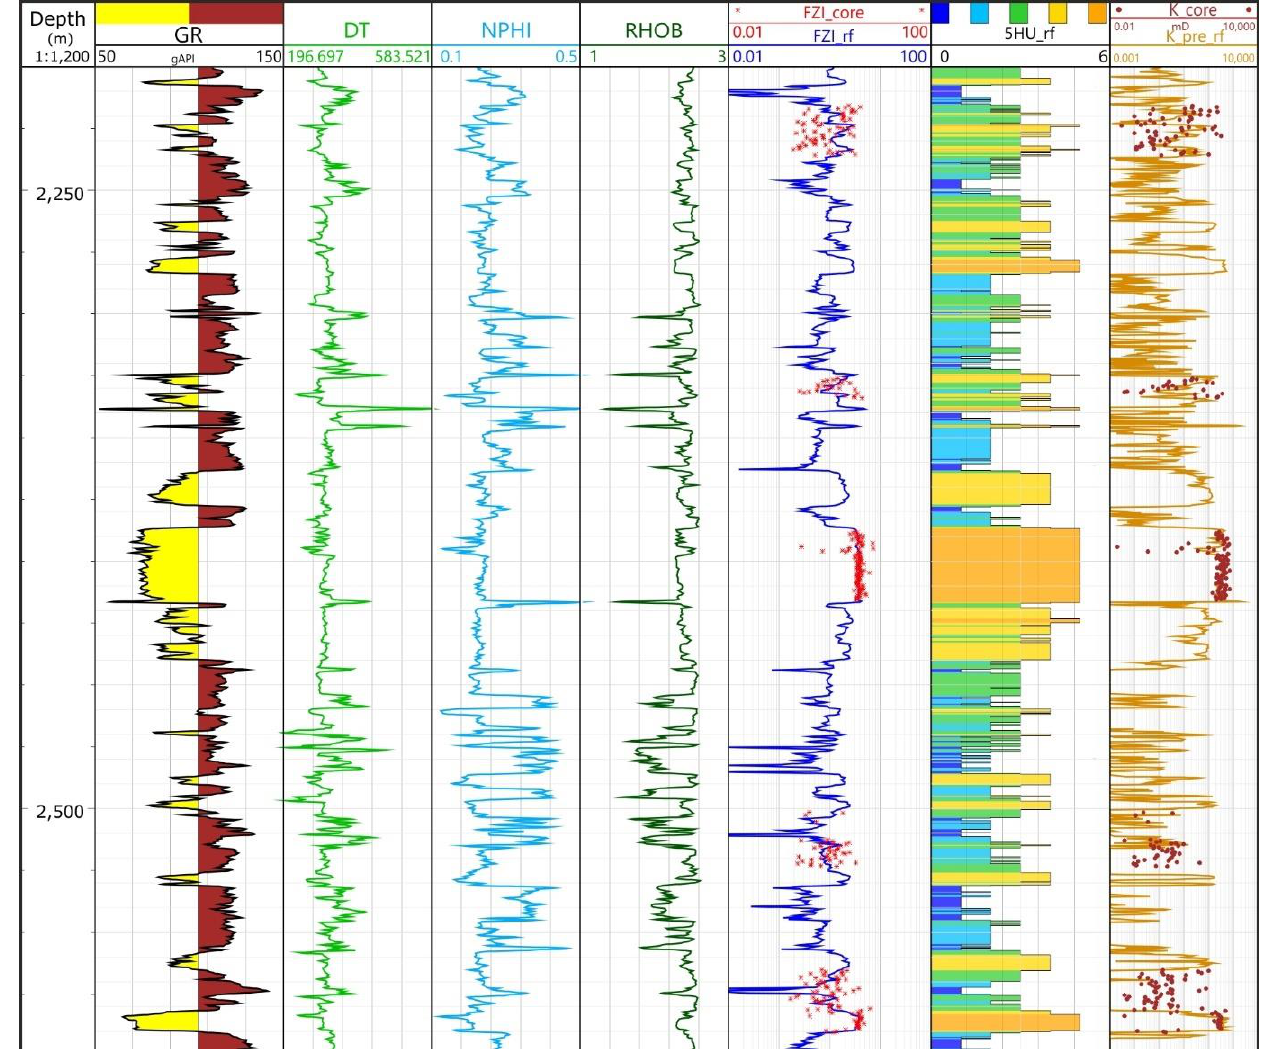
Figure 13. The logs curves (GR, DT, NPHI, RHOB) and FZI prediction, HU classification and permeability estimated by applying the Random Forest method.